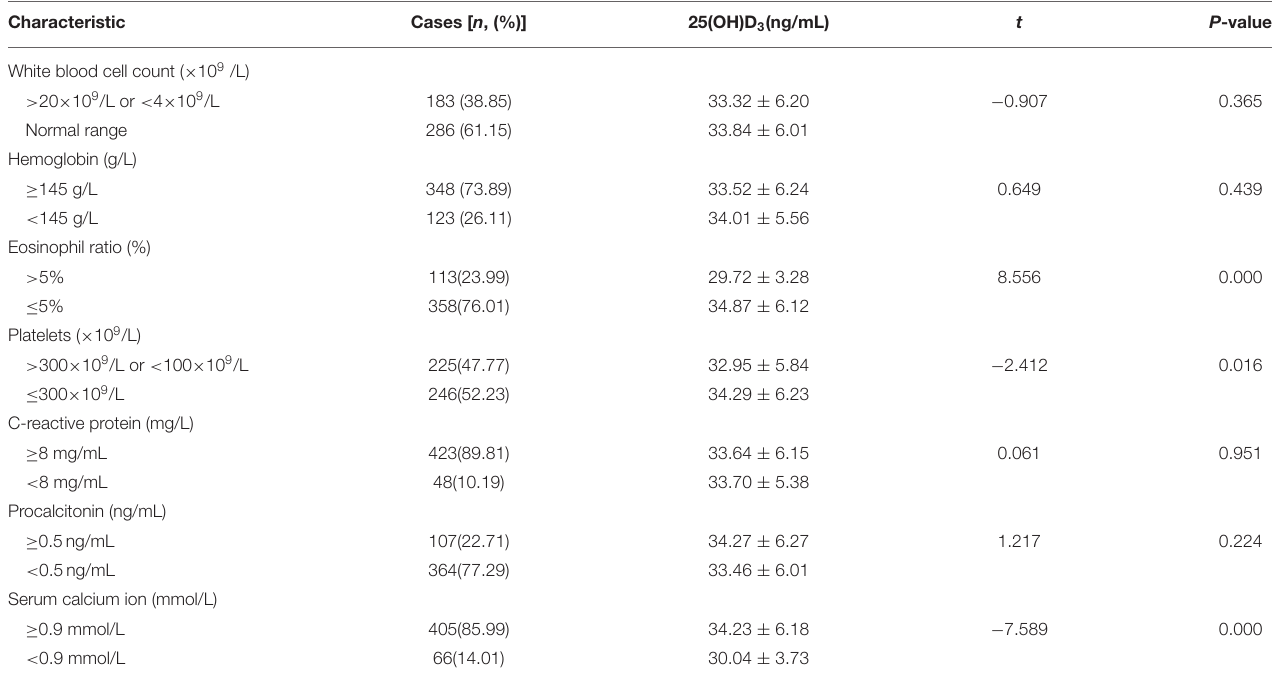
TABLE 3 | Results of laboratory examinations of neonates.